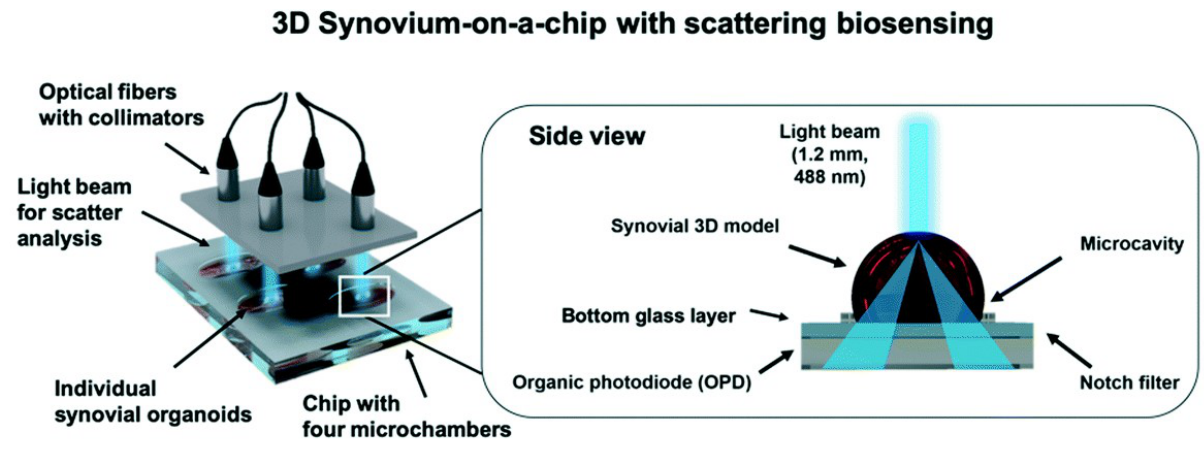
Figure 8. Investigation of tissue-level remodeling in regard to inflammatory arthritis, reproduced from open access article Ref. [153]. Graphic showing setup of the chip with integrated biosensors, consisting of four separate microchambers that hold human synovium organoids. Using organic photodiodes below the chip, light scatter measurements are recorded through the separate synovial